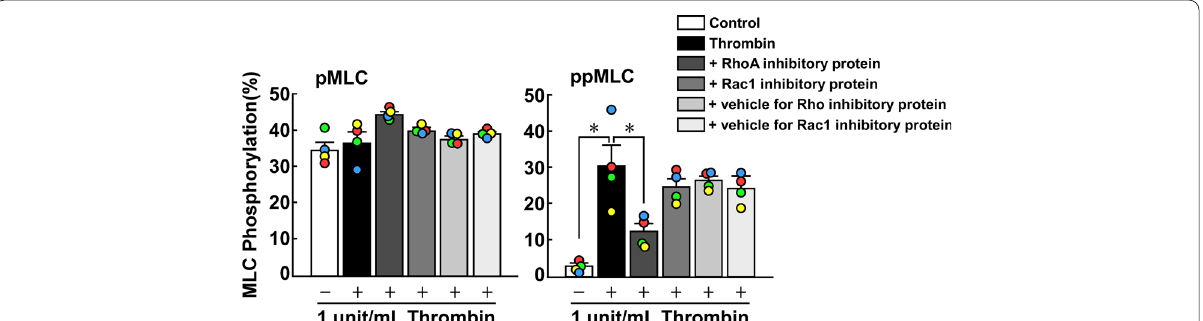
Fig. 5 Effects of introduction of the inhibitory proteins of RhoA and Rac1/Cdc42 on the thrombin-induced mono- and di-phosphorylation of MLC (pMLC and ppMLC) in porcine aortic endothelial cells (PAECs). PAECs were pretreated with 5 μM inhibitory proteins of RhoA and Rac1/Cdc42 for 30 min prior to and during stimulation with 1 unit/mL thrombin. MLC phosphorylation was evaluated with Phos-tag SDS-PAGE followed by immunoblot detection of MLC. The data are expressed as the mean